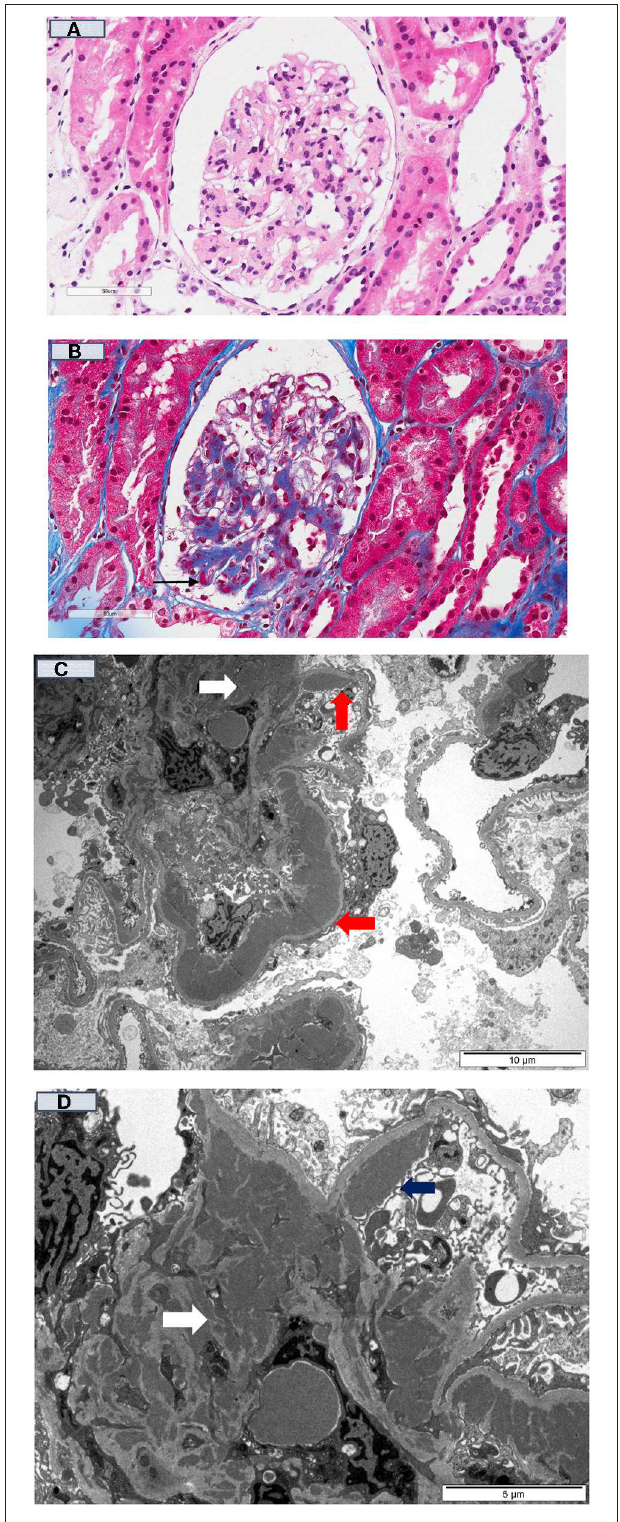
FIGURE 2 | Kidney transplant recipient who had developed recurrent MPGN 12-months post-transplant. (A) [H & E (40x)]: Kidney allograft biopsy showed